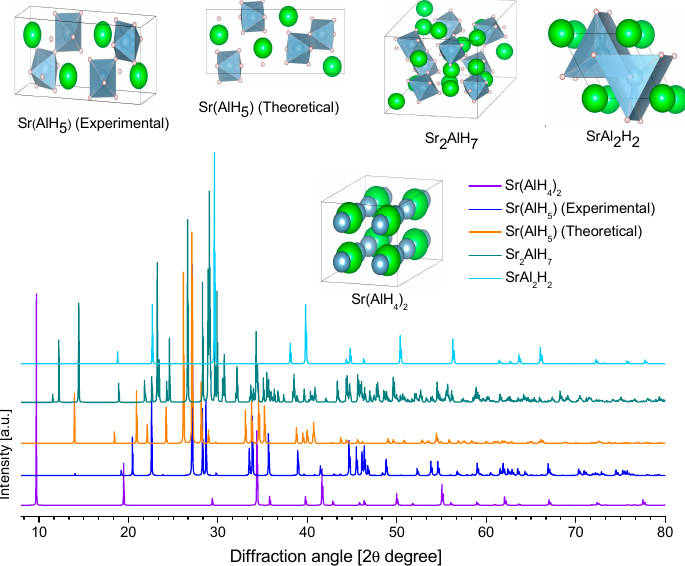
Figure 17. Crystal structure of strontium alanates and their calculated diffraction patterns ( λ = Cu k α 1 ).